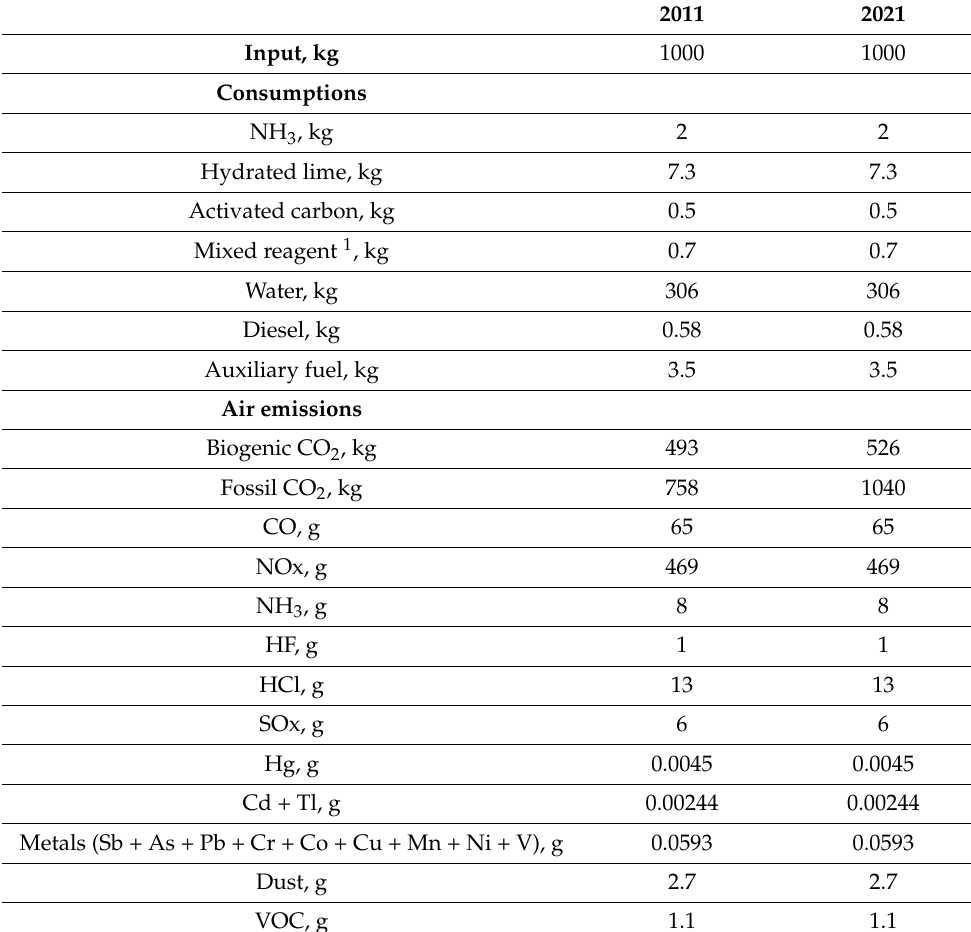
Table 4. Direct and avoided burdens related to management of solid recovered fuel obtained from unsorted residual waste (EWC 200301). Data Source: